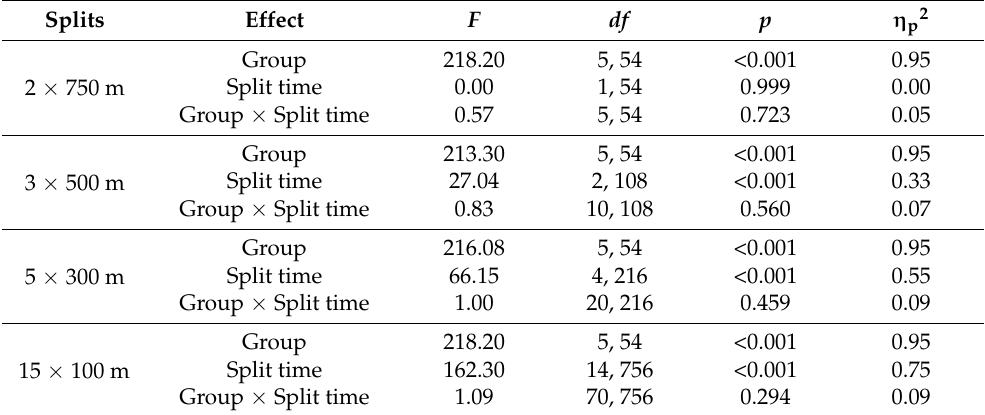
Table 1. Summarized variance analysis of the recorded split times in the 1500 m swimming perfor- mance categorized by the number of splits and subsequent groups of swimmers. Splits